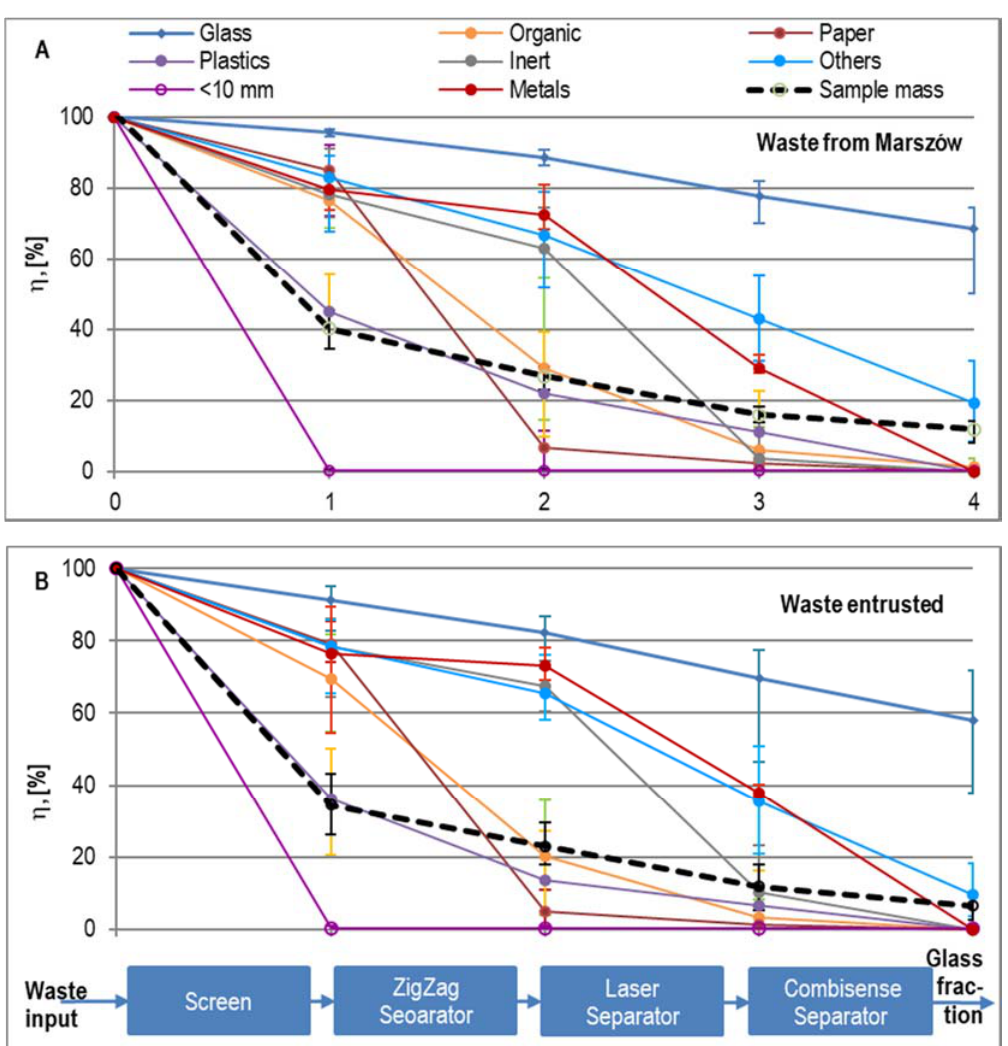
Figure 5. Recovery ( η ) of material components in the subsequent stages of the process of separating glass fractions from the stabilizer (average values: 13 series of waste from Marszów, 6 series of waste from other plants). ( A ) waste from Marszów ( B ) waste entrusted